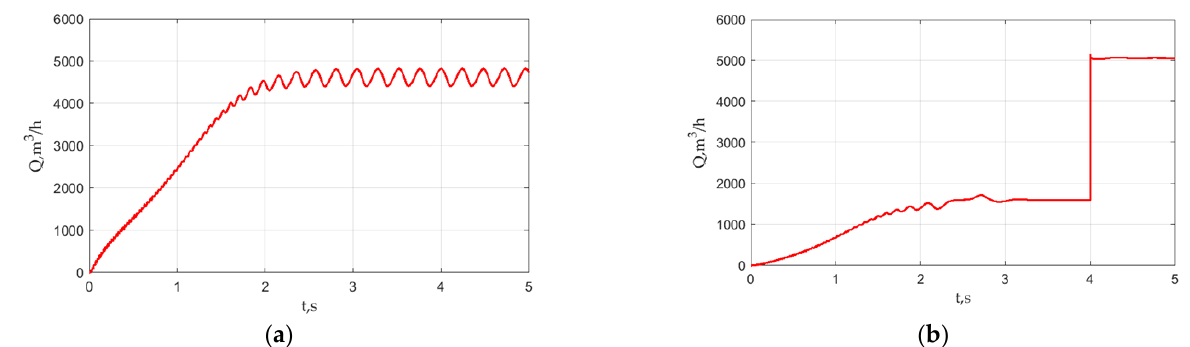
Figure 9. Flow versus time, 380 V: ( a ) Fully open valve; ( b ) fully closed